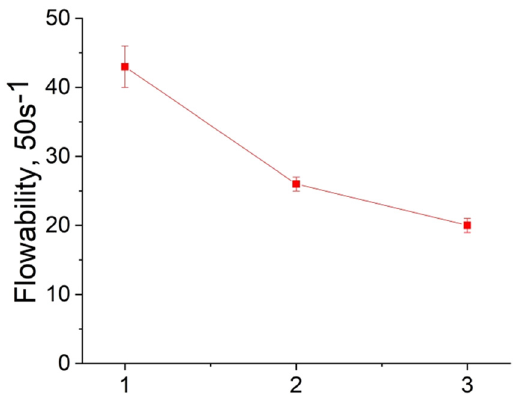
Figure 10: Flowability of the powder: ( 1 ) initial, ( 2 ) after spheroid - ization, and ( 3 ) after